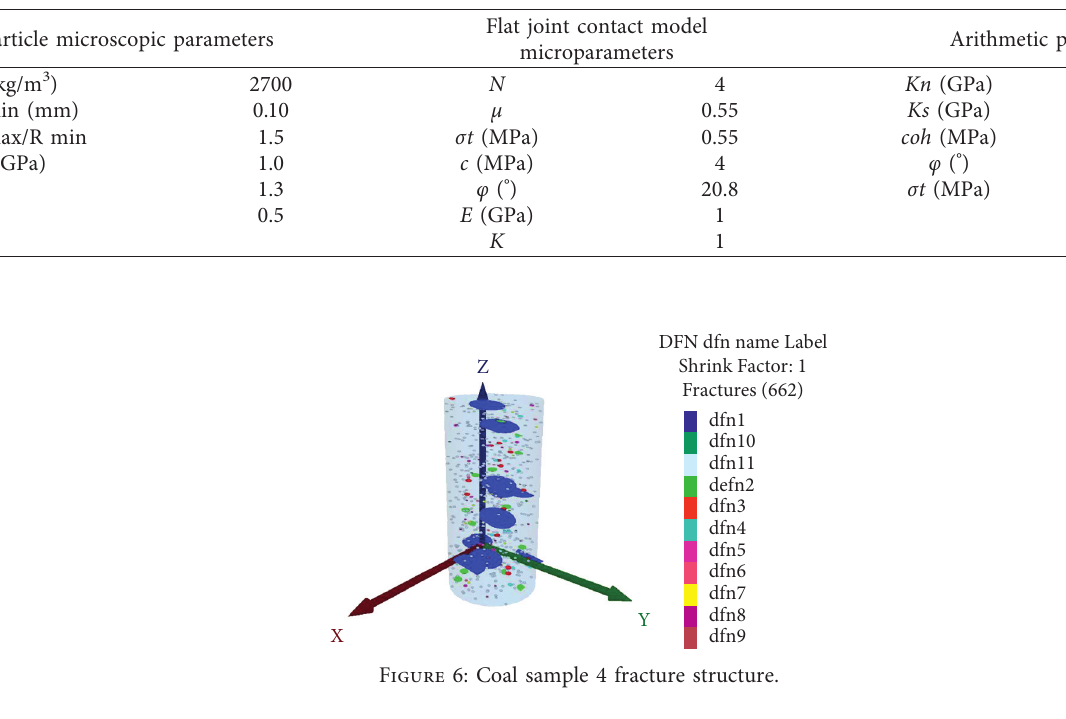
Table 2: Microscopic parameters of the coal sample model.